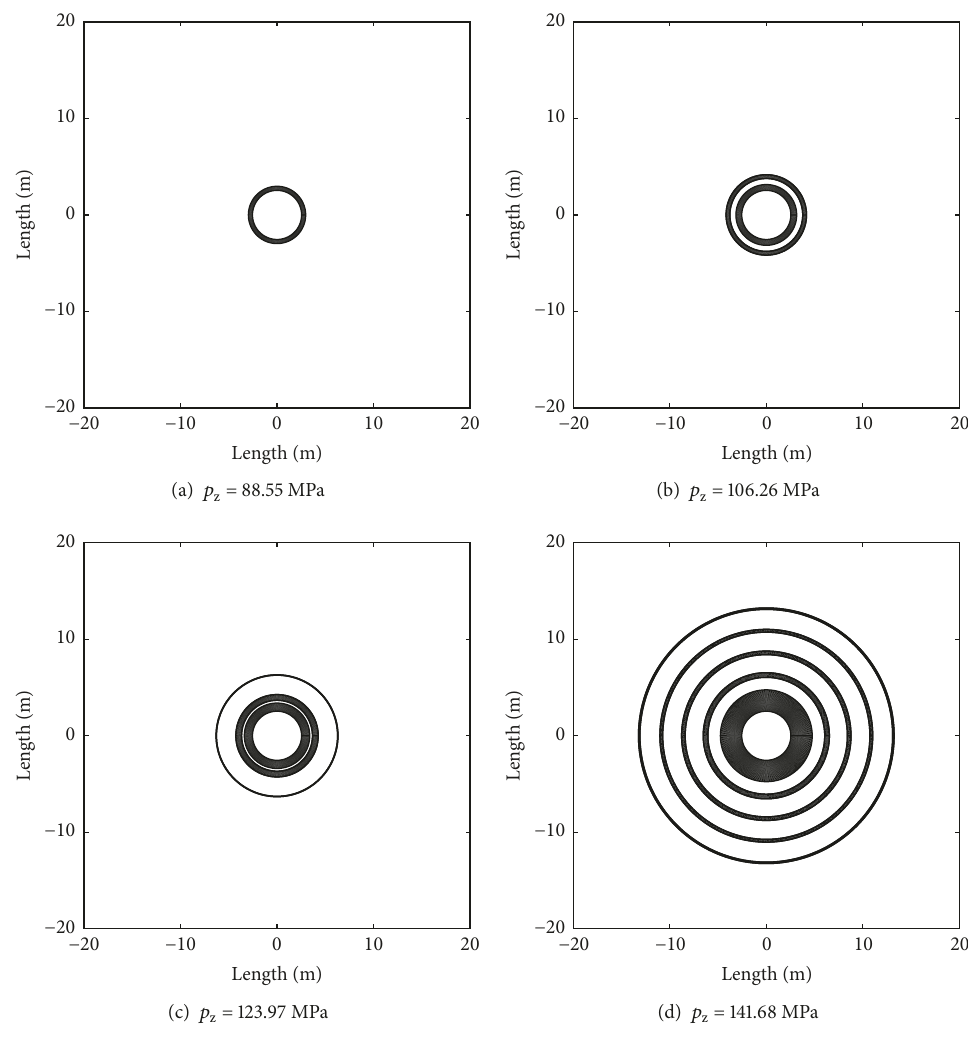
Figure 7: Effect of high axial geostress 𝑝 z on zonal